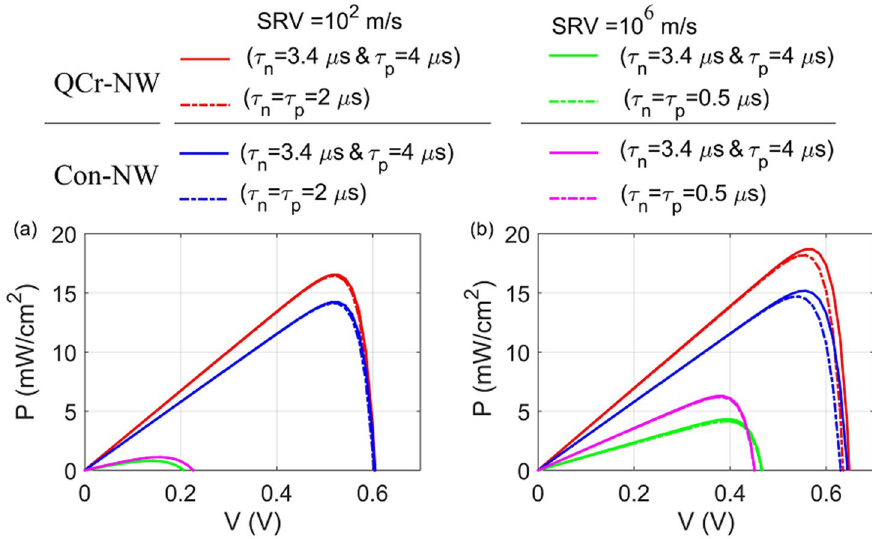
Figure 15. P–V characteristics for the studied designs at good ( 10 2 m/s) and bad ( 10 6 m/s) surface passivation with and without lifetime-dependent surface defects for the ( a ) axial junction and ( b ) core–shell junction.